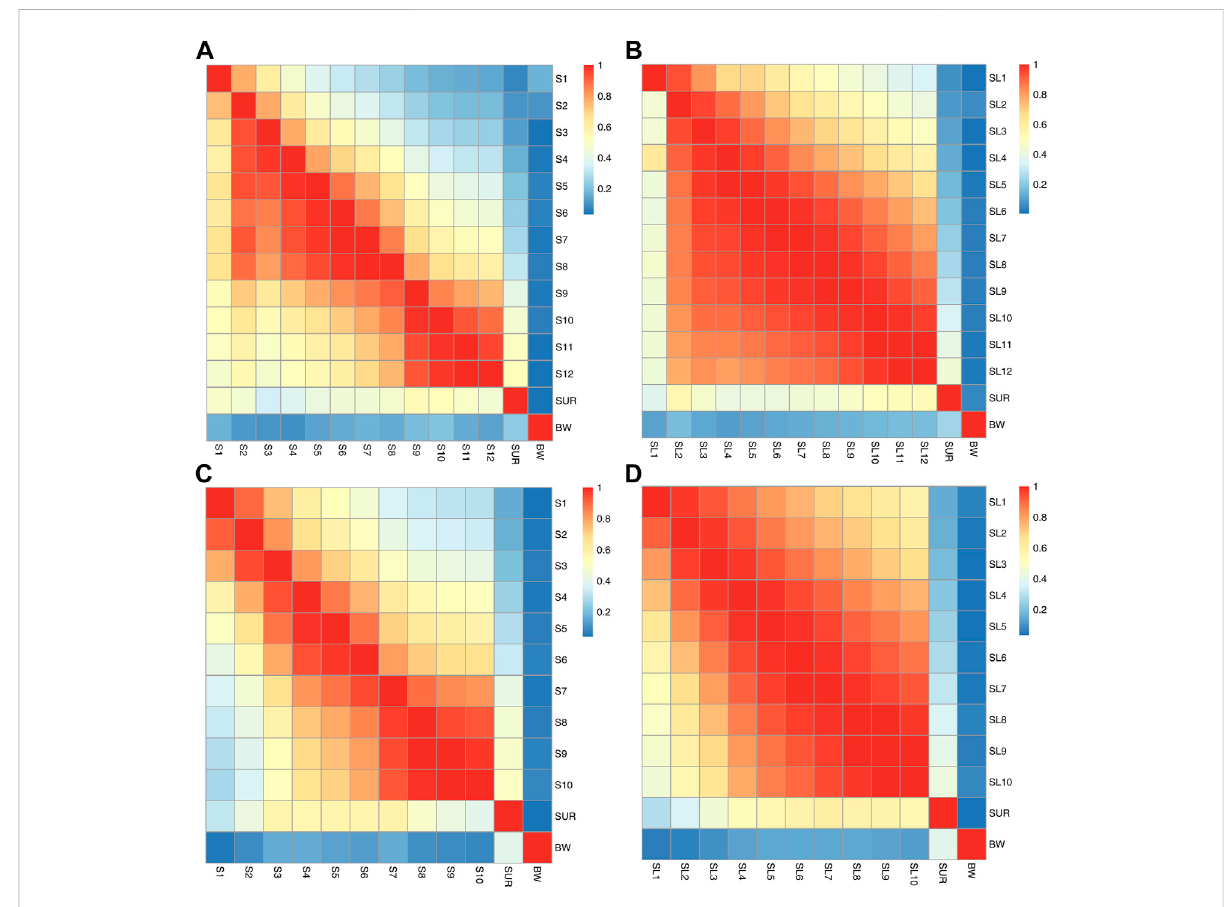
FIGURE 3 Thetrajectoryofphenotype(abovediagonal)andgeneticcorrelations(belowdiagonal)between (A) S1-S12,SURandBWforthebreedinglineof BL 2019, (B) SL1-SL12, SUR and BW of BL 2019, (C) S1-S10, SUR and BW for the breeding line of BL 2020, (D) SL1-SL10, SUR and BW for the breeding line of BL